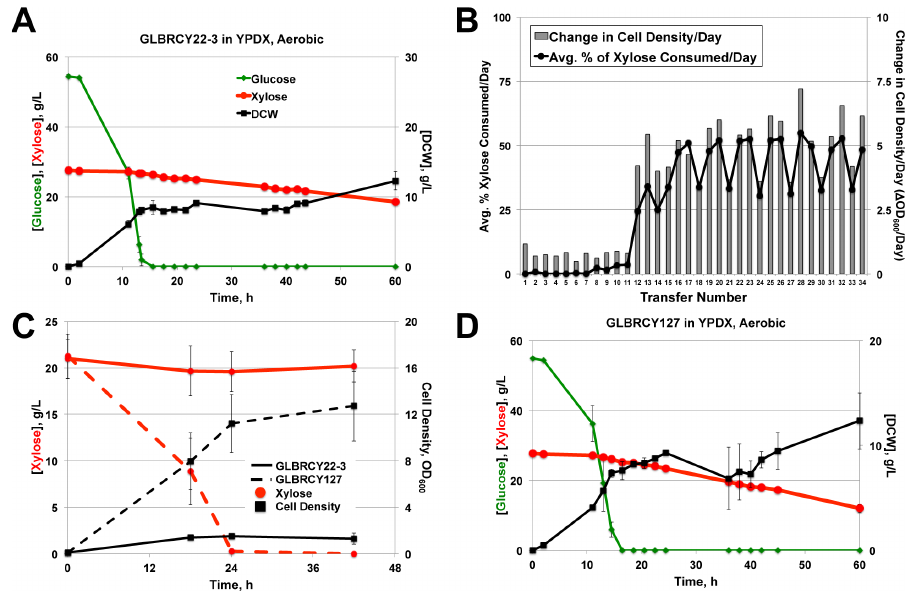
Figure 2. The GLBRCY127 strain developed by directed engineering with xylose isomerase coupled with batch evolution can rapidly consume xylose aerobically. Average sugar consumption and cell growth of unevolved GLBRCY22-3 strain engineered with ScTAL1 , CpxylA and SsXYL3 cultured in bioreactors containing YPDX media and sparged with air from biological duplicates is shown ( A ). Indicated components were quantified from media samples at times from initial inoculation. In ( B ), the average percentage of xylose consumed and change in cell density per day are plotted for each transfer during the adaption of the Y22-3 strain in YP media containing 0.1% glucose and 2% xylose. The pattern of lower % of xylose consumed and change in cell density per day during every third transfer is due to reaching saturated growth prior to transfer. Average extracellular xylose concentrations and cell density measurements from parental Y22-3 and evolved Y127 strains grown aerobically in culture tubes with YPX media from three independent biological replicates are plotted in ( C ). In ( D ), evolved isolate Y127 was cultured in the same conditions as in ( A ), and samples measurements taken in an identical manner.